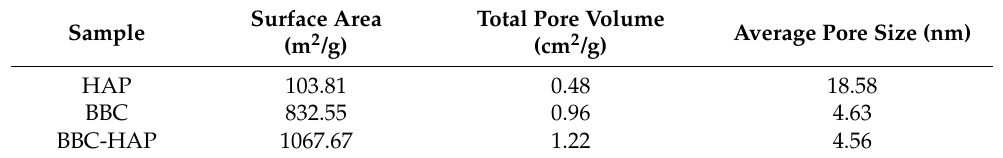
Figure 3. ( a ) N 2 adsorption–desorption isotherms and ( b ) pore size distributions of HAP, BBC and BBC ‐ HAP. ( c ) FTIR spectra of HAP, BBC, BBC ‐ HAP and BBC ‐ HAP ‐ Colorant. ( d ) XRD patterns of HAP, BBC and BBC ‐ HAP. Table 2. HAP, BBC, and BBC-HAP surface areas, total pore volumes, and average pore